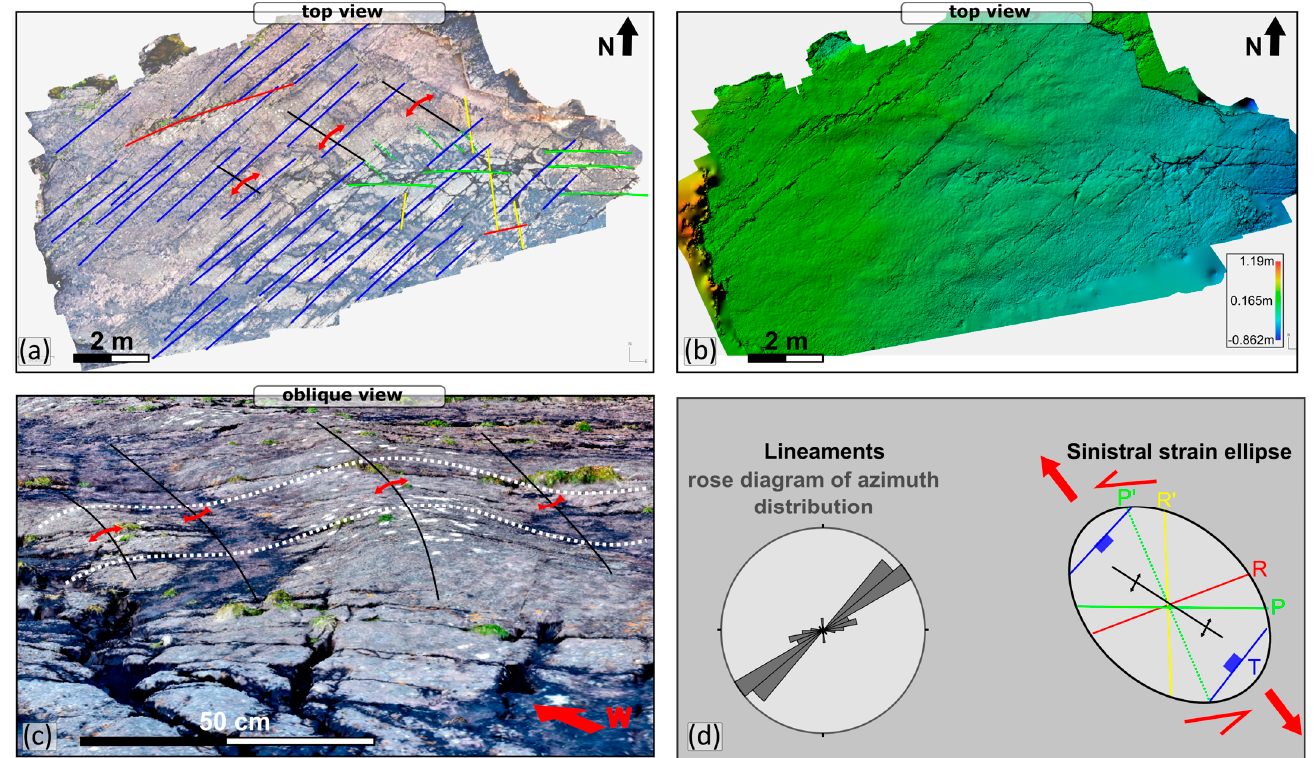
Figure 9. ( a ) Orthomosaic and ( b ) DEM model along strike of Figure 8f (see location on Figure 4b) showing en-echelon fractures array and small-scale folds also shown in oblique view in ( c ). ( d ) Rose diagram of azimuth distributions and strain ellipse showing fault array geometry suggesting a component of sinistral shear movement. Colours match the colours in ( a ) and (Figure 8f).